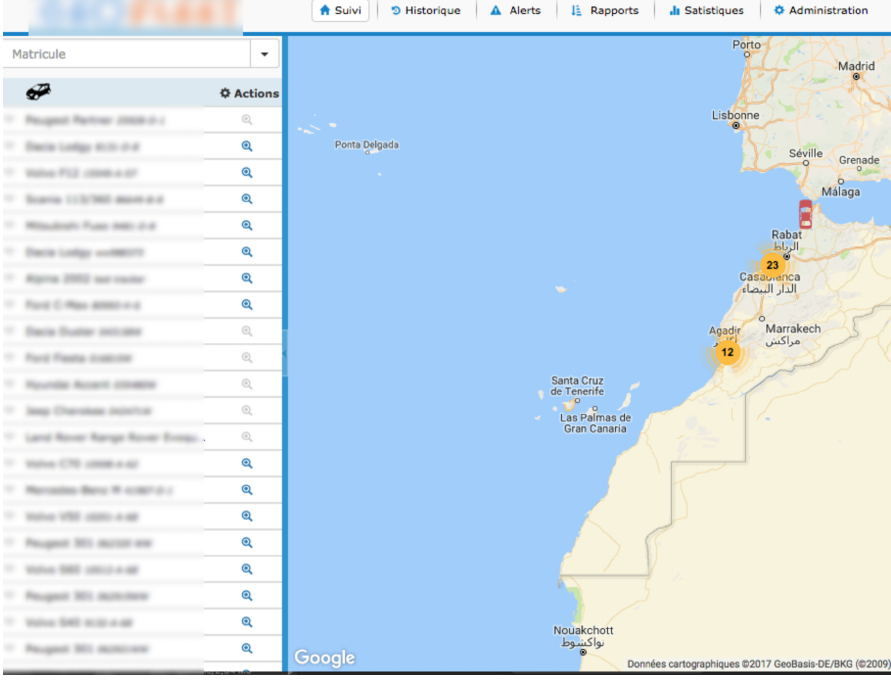
Figure 7. Real-time monitoring